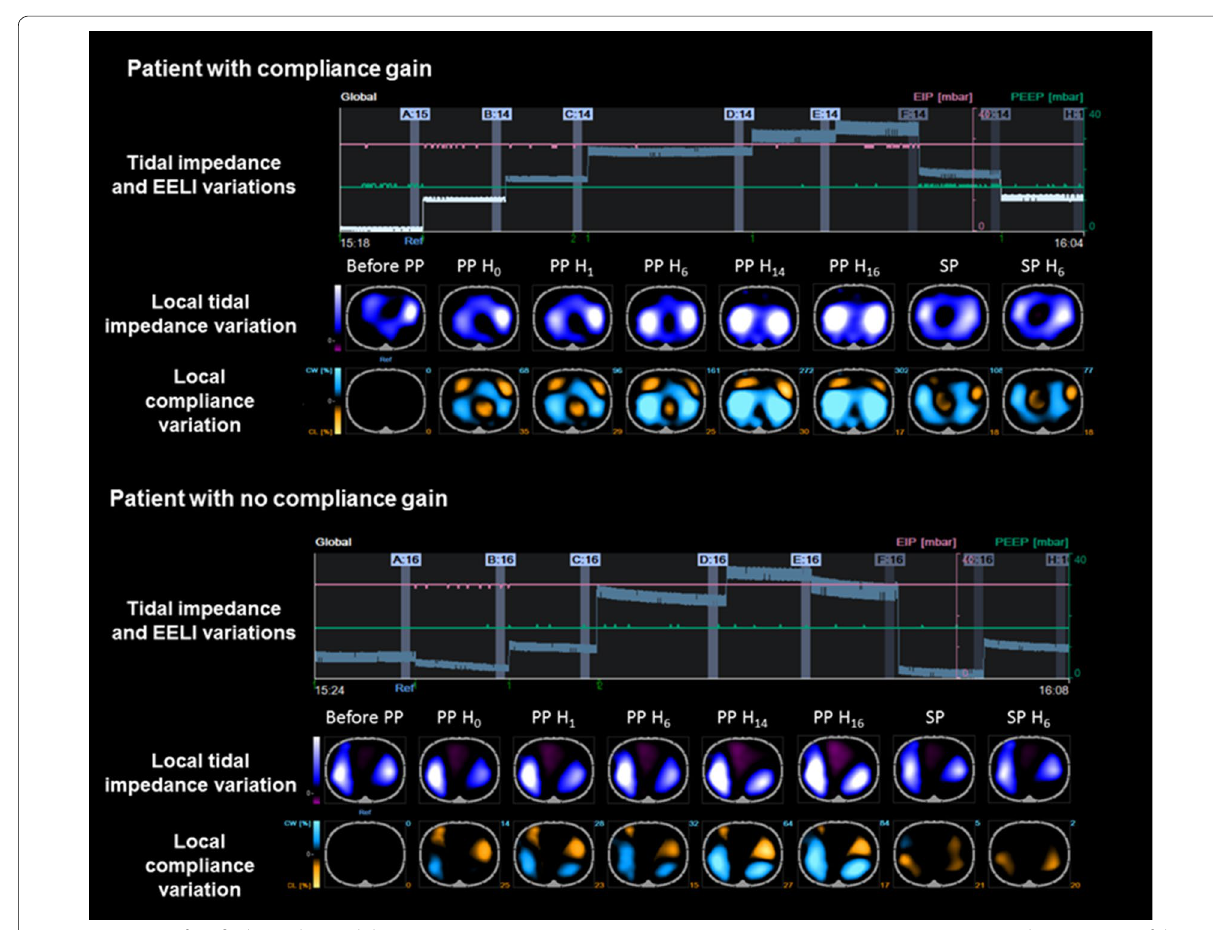
Fig. 4 Summary of EIT findings obtained during a prone‑positioning (PP) session in two representative patients, a patient with an increase of the static compliance by 3 mL/cmH 2 O after 16‑h of PP and a patient with static compliance ˂ 3 mL/cmH 2 O, respectively. EELI end‑expiratory lung ≥ impedance, H hour. For graphic illustration of tidal impedance variation (∆impedance), the lighter the zone, the greater the ∆impedance, meaning that ∆impedance is higher in white zones than blue zones. For local compliance variation distribution, blue regions reflect a compliance gain compared to baseline (i.e., before PP), whereas yellow regions represent a compliance